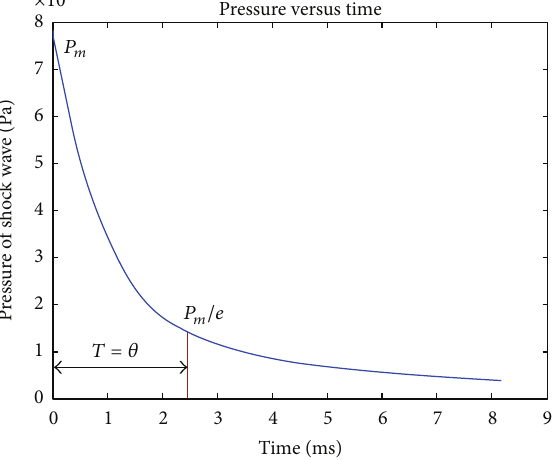
Figure 3: Top view of cylindrical shell.